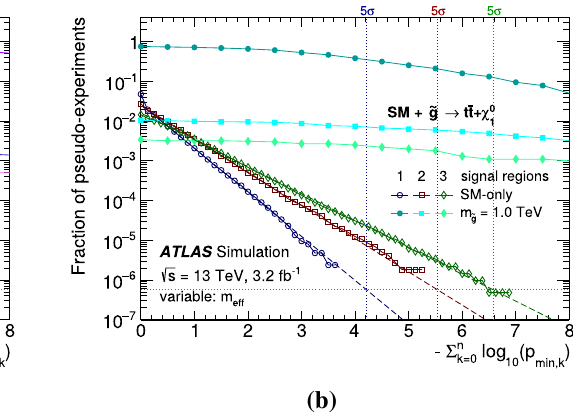
mass m Z (cid:8) = 2 . 5 TeV or b gluino pairs with mass m ˜ g = 1 . 0 TeV and g → t ¯ t ˜ χ 0 decays. The signal region tested in the follow-up 1 pseudo-experiment isdefinedbythe precedingpseudo-experiment. The 5 σ thresholds are obtained by extrapolating the SM-only fractions to 5 . 7 · 10 − 7 and are indicated at the top of the figure for n = 1 (left), n = 2 (middle) or n = 3 (right) event